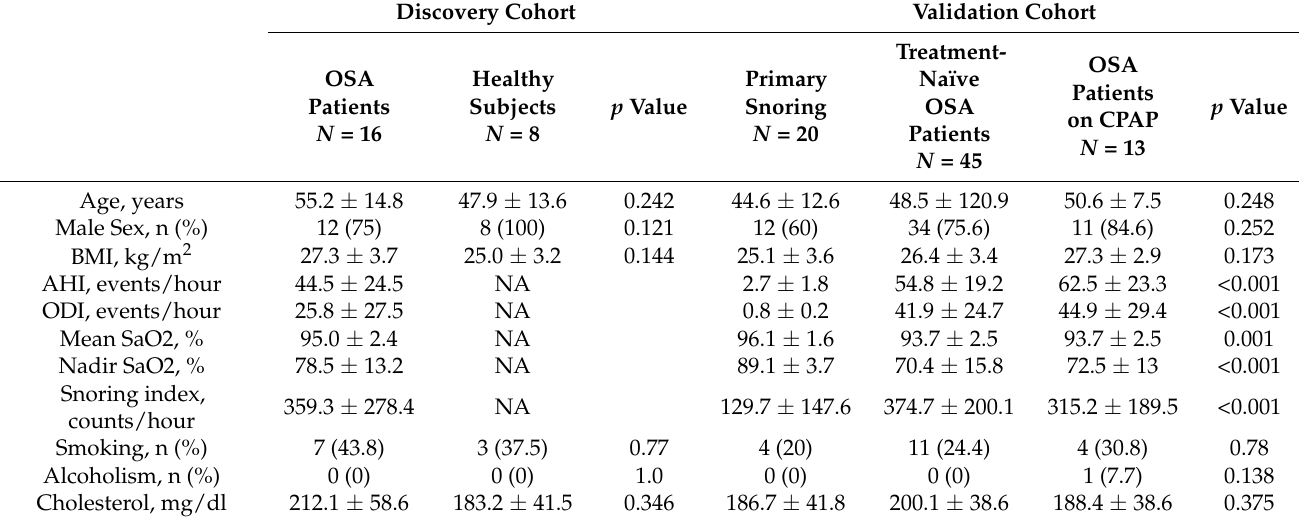
Table 1. Demographic, sleep, and biochemistry data of the discovery and validation